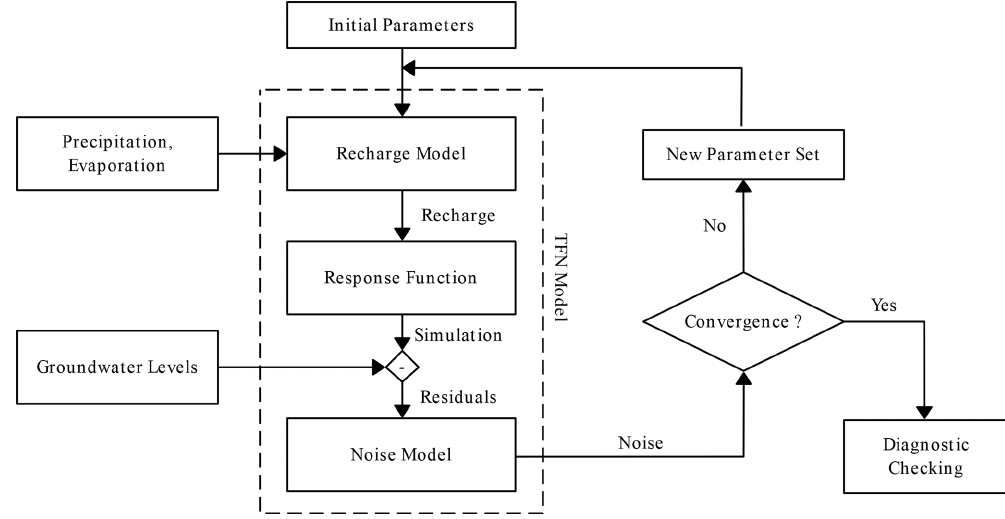
Figure 6. Modeling strategy as applied in this